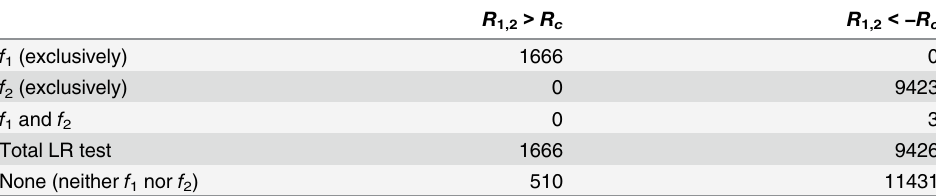
Table 2. Number of texts with a significant LR test.